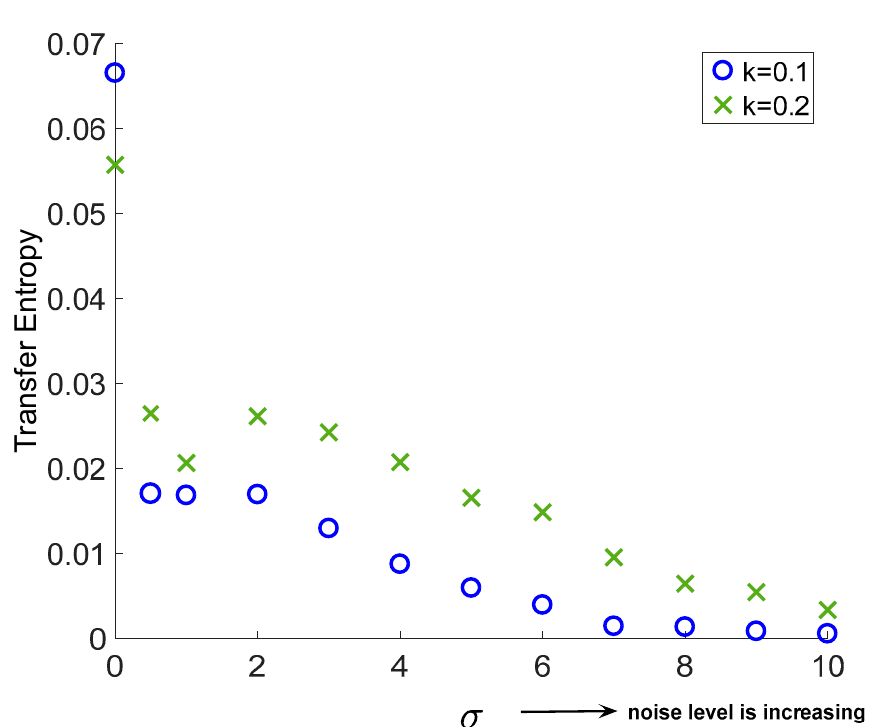
Figure 3. Transfer entropy results for 2-to-1 and 1-to-1 coupled HH